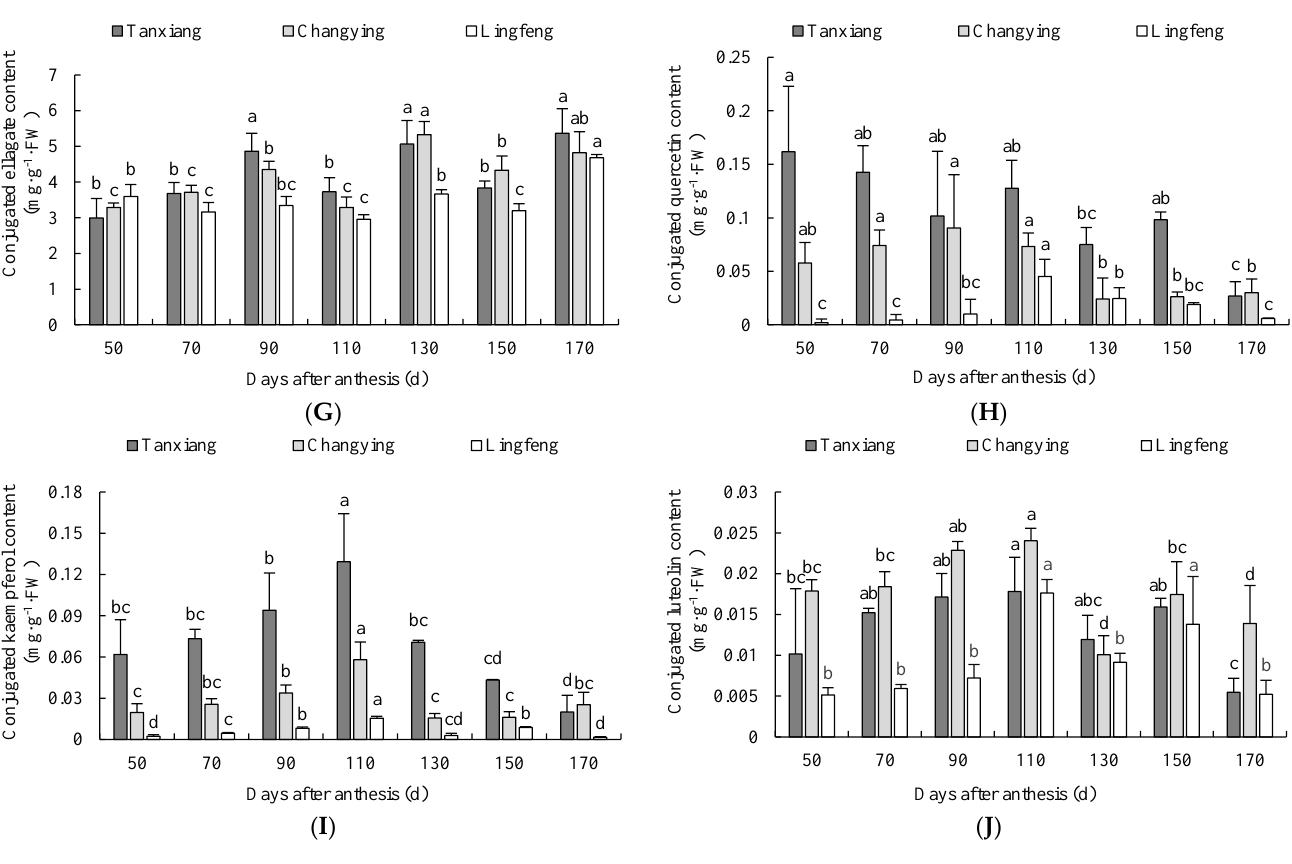
Figure 2. Content of shikimate, quinate and phenolic substances in Chinese olive fruit at different developmental stages. Bars represent the standard deviation for three biological replicates. Different letters indicate significant differences among different stages of the same cultivars ( p < 0.05). ( A ) Shikimate, ( B ) quinate, ( C ) free ellagate, ( D ) (iso)corilagin, ( E ) hyperoside, ( F ) conjugated gallate, ( G ) conjugated ellagate, ( H ) conjugated kaempferol, ( I ) conjugated quercetin and ( J ) conjugated luteolin.